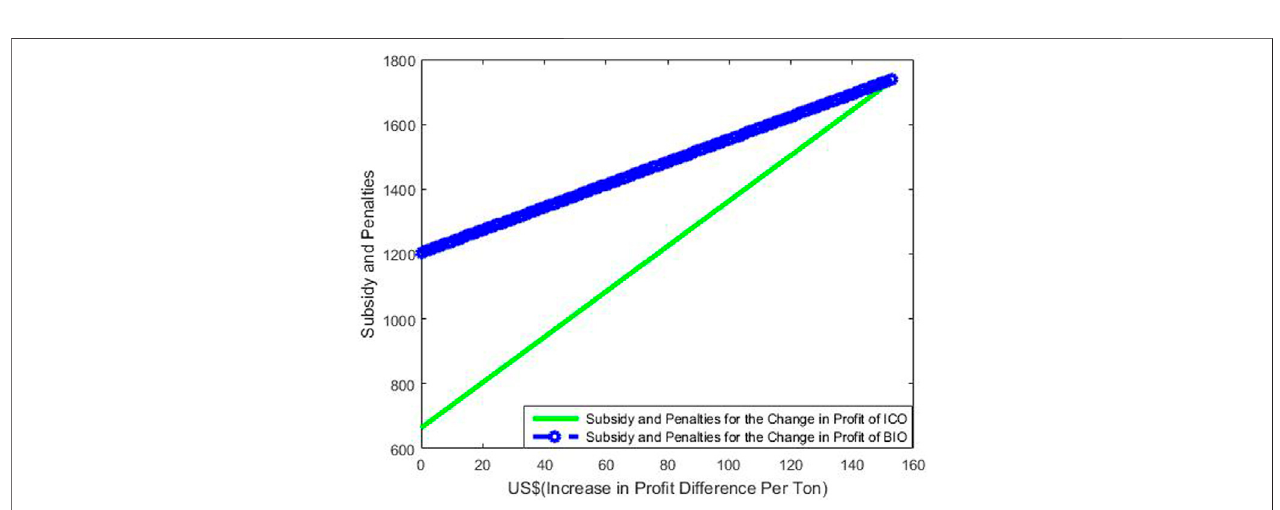
FIGURE 7 | The effect of changes in pro fi t for TFT on the sum of subsidies and penalties.